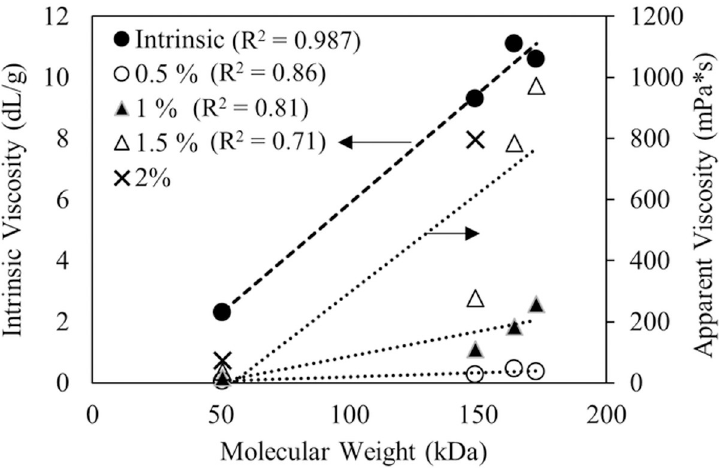
Fig 6. Intrinsic viscosity of alginates (primary axis) and apparent viscosities of alginate solutions at varying concentrations (secondary axis) plotted with respect to average molecular weights. R 2 values of regression lines are shown next to the corresponding legend. See S1 File for additional information on alginate solution viscosities.